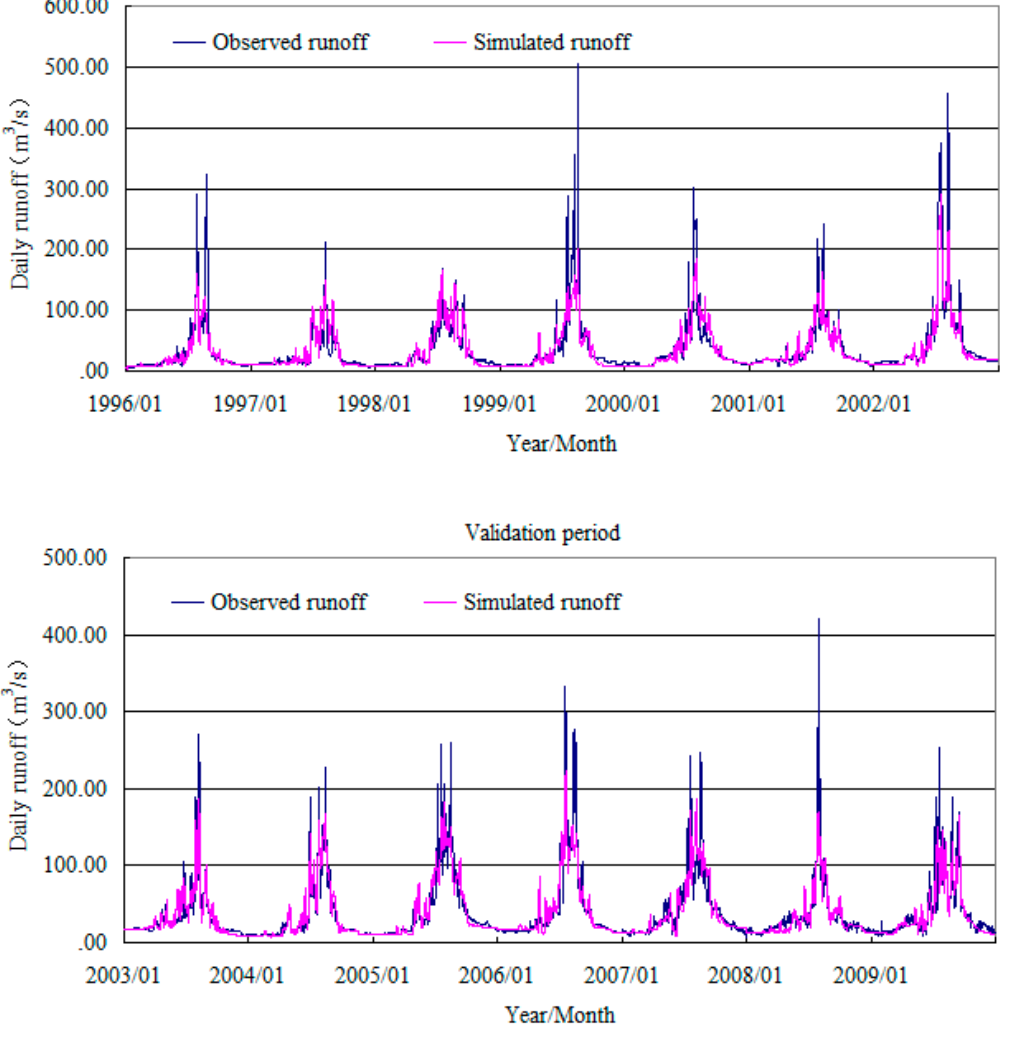
Figure 3. Simulated and observed runoff in the upper reaches of the Shule River. Table 1. Simulated daily runoff in the study area during the summer half of the year (S), the winter half of the year (W) and the entire year (E).